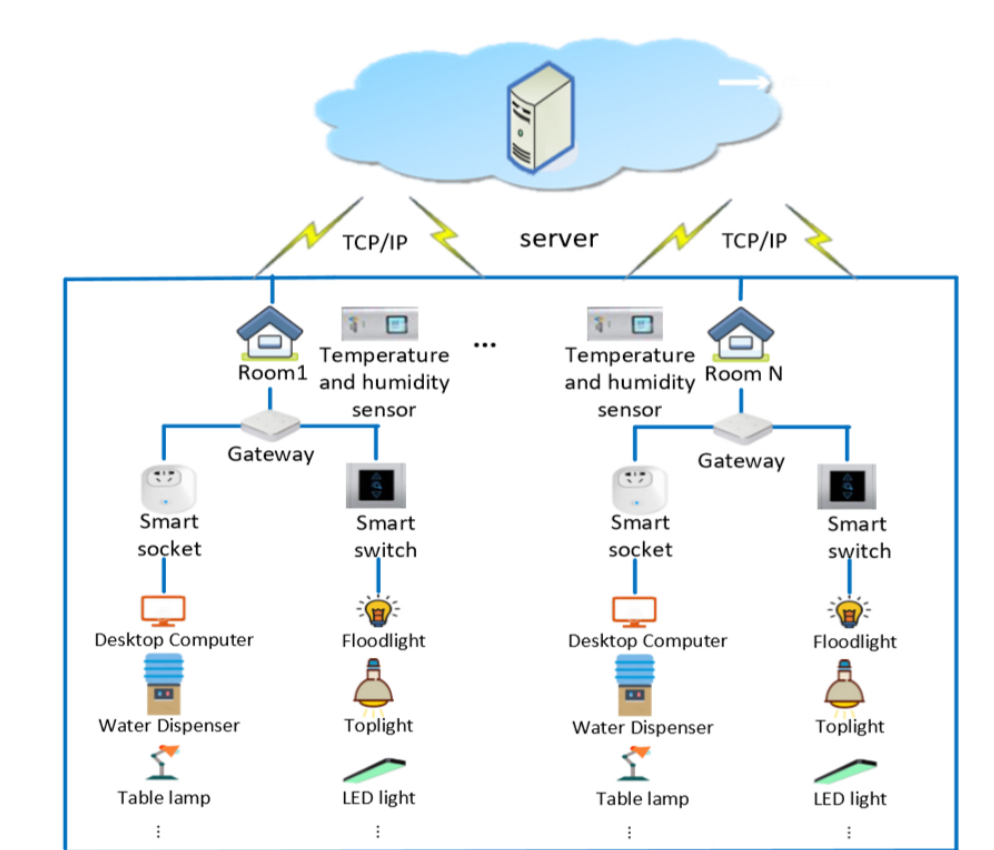
Figure 1. Architecture of the indoor electrical Internet of Things system.